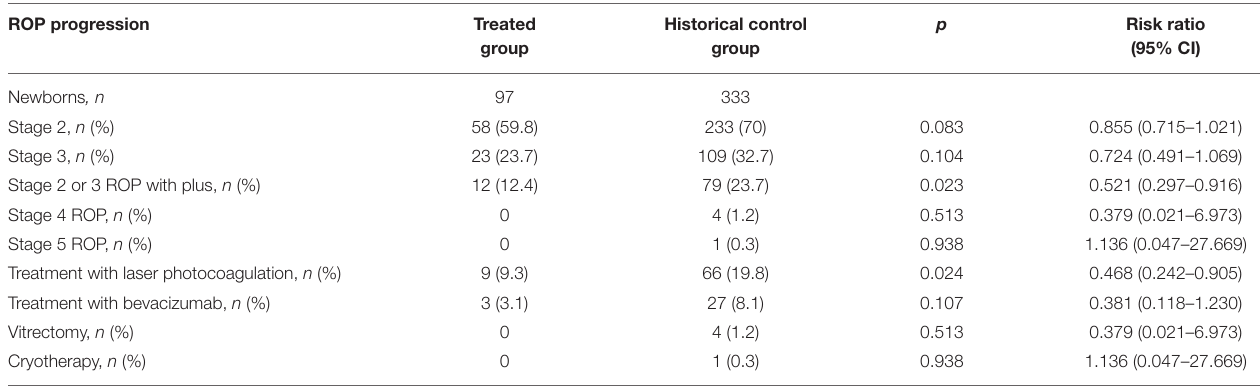
TABLE 3 | Ophthalmologic